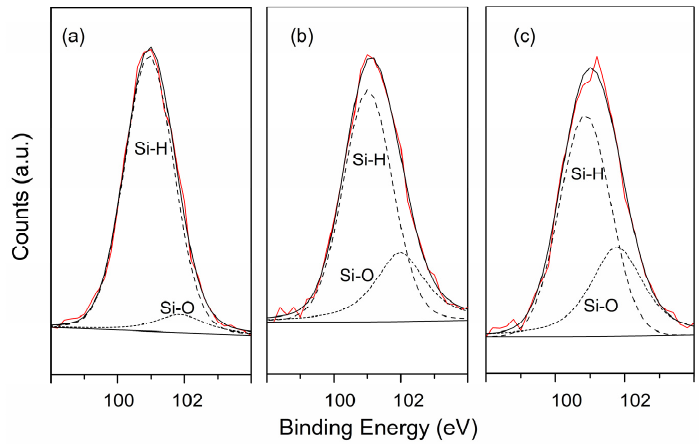
Figure 4. X-ray photoelectron spectra (XPS) spectra of the polymerization products of C 18 H 37 SiH 3 by using ( a ) 0.01 g ZIF-8 30 °C; ( b ) 0.01 g ZIF-8 90 °C; ( c ) 0.03 g ZIF-8 90 °C.